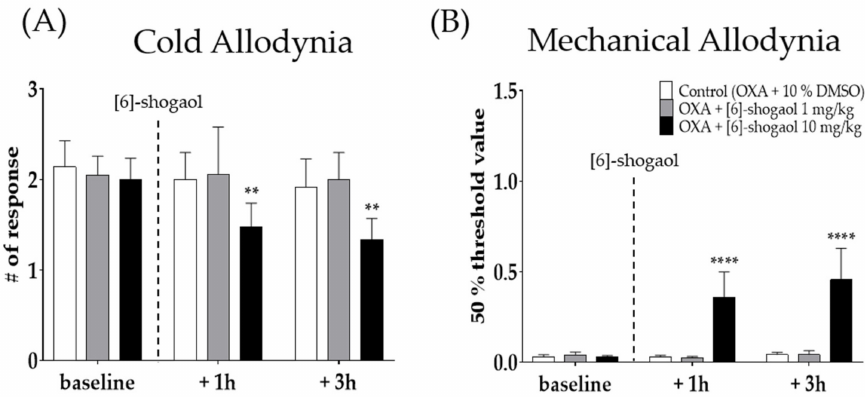
Figure 2. The analgesic effect of intraperitoneal injection of [6]-shogaol in oxaliplatin-induced allodynia in mice ( A , B ). Behavioral tests were conducted four days after 6 mg/kg of oxaliplatin (i.p.) injection. Cold allodynia ( A ) was assessed by using acetone drop test and mechanical allodynia ( B ) was measured by using von Frey filament test. Control group mice were treated with 10% of DMSO. Two different doses of [6]-shogaol was used (1 and 10 mg/kg). Baseline: before the injection of 10% DMSO or [6]-shogaol. +1 h: 1 h after 10% DMSO or [6]-shogaol treatment. +3h: 3 h after injection of 10% DMSO or [6]-shogaol administration. Data are presented by mean ± SEM. Control (OXA + 10% DMSO): n = 6, OXA + [6]-shogaol 1 mg/kg: n = 6, OXA + [6]-shogaol 10 mg/kg: n = 6. ** p < 0.01, **** p < 0.0001 vs. Control with two-way ANOVA followed by Tukey’s multiple comparisons test.